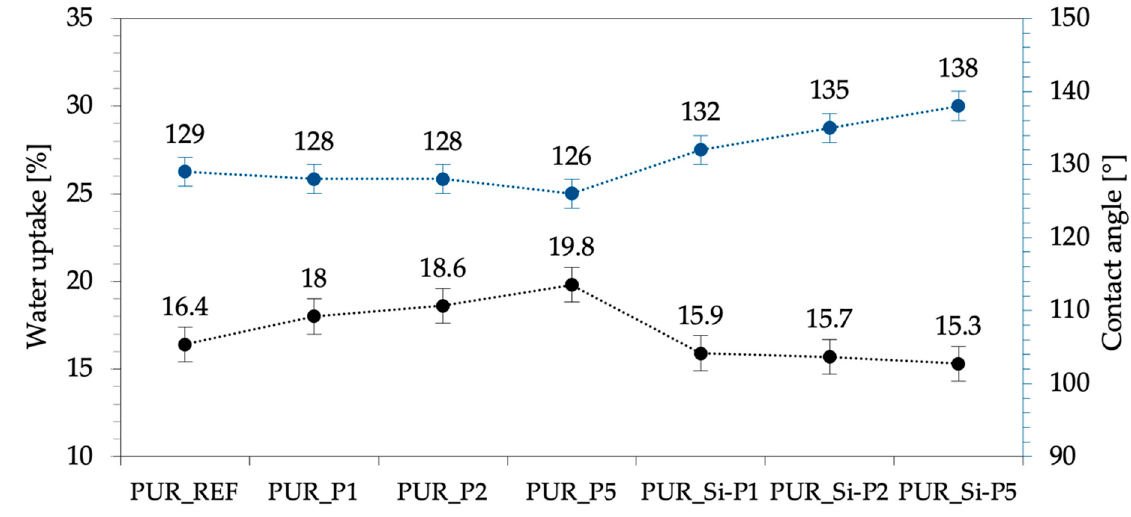
Figure 11. Selected properties of PUR foams: water uptake and contact angle results.